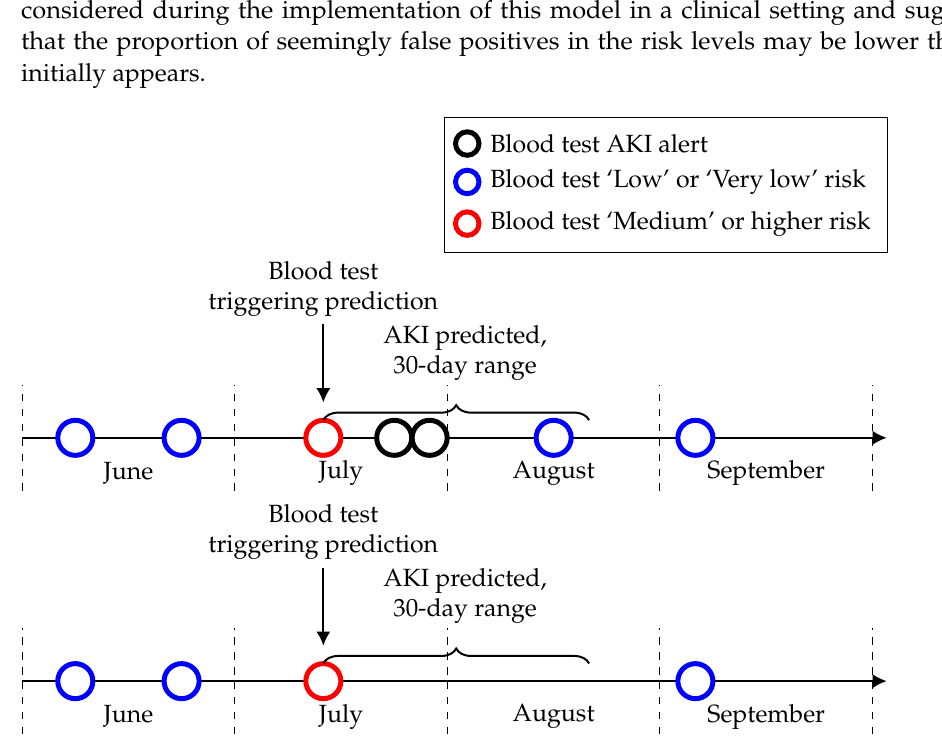
Figure 5. Examples of prediction timelines for patient blood tests. The top image shows an AKI being confirmed after a blood test risk level of ‘Medium’ or higher whilst the bottom one shows an AKI being unable to be confirmed due to a lack of blood tests in the follow up time-frame. Each circle in this figure represents a blood test with the legend denoting a blood test either giving an AKI alert, a ‘Low’ or ‘Very low’ risk level or a ‘Medium’ or higher risk level triggering an AKI